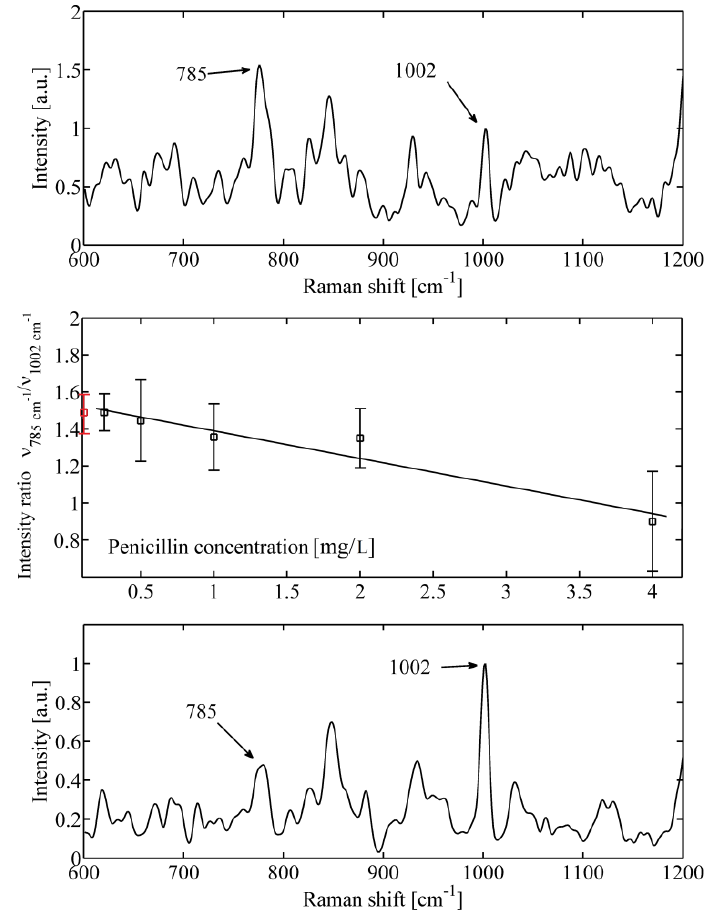
Figure 3. An example of Staphylococcus epidermidis response to bactericidal action of penicillin. ( a ) Top—Raman spectrum obtained for low antibiotic concentration (0.2